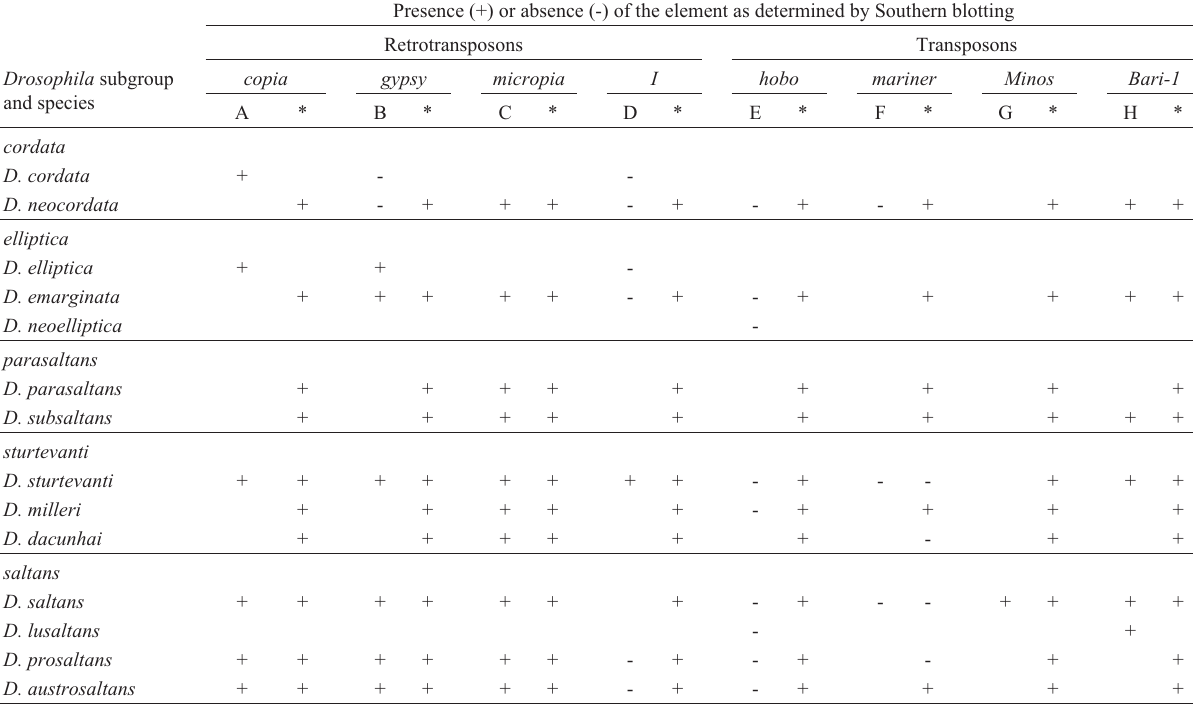
Table 3 - Distribution of transposable elements in species of the saltans